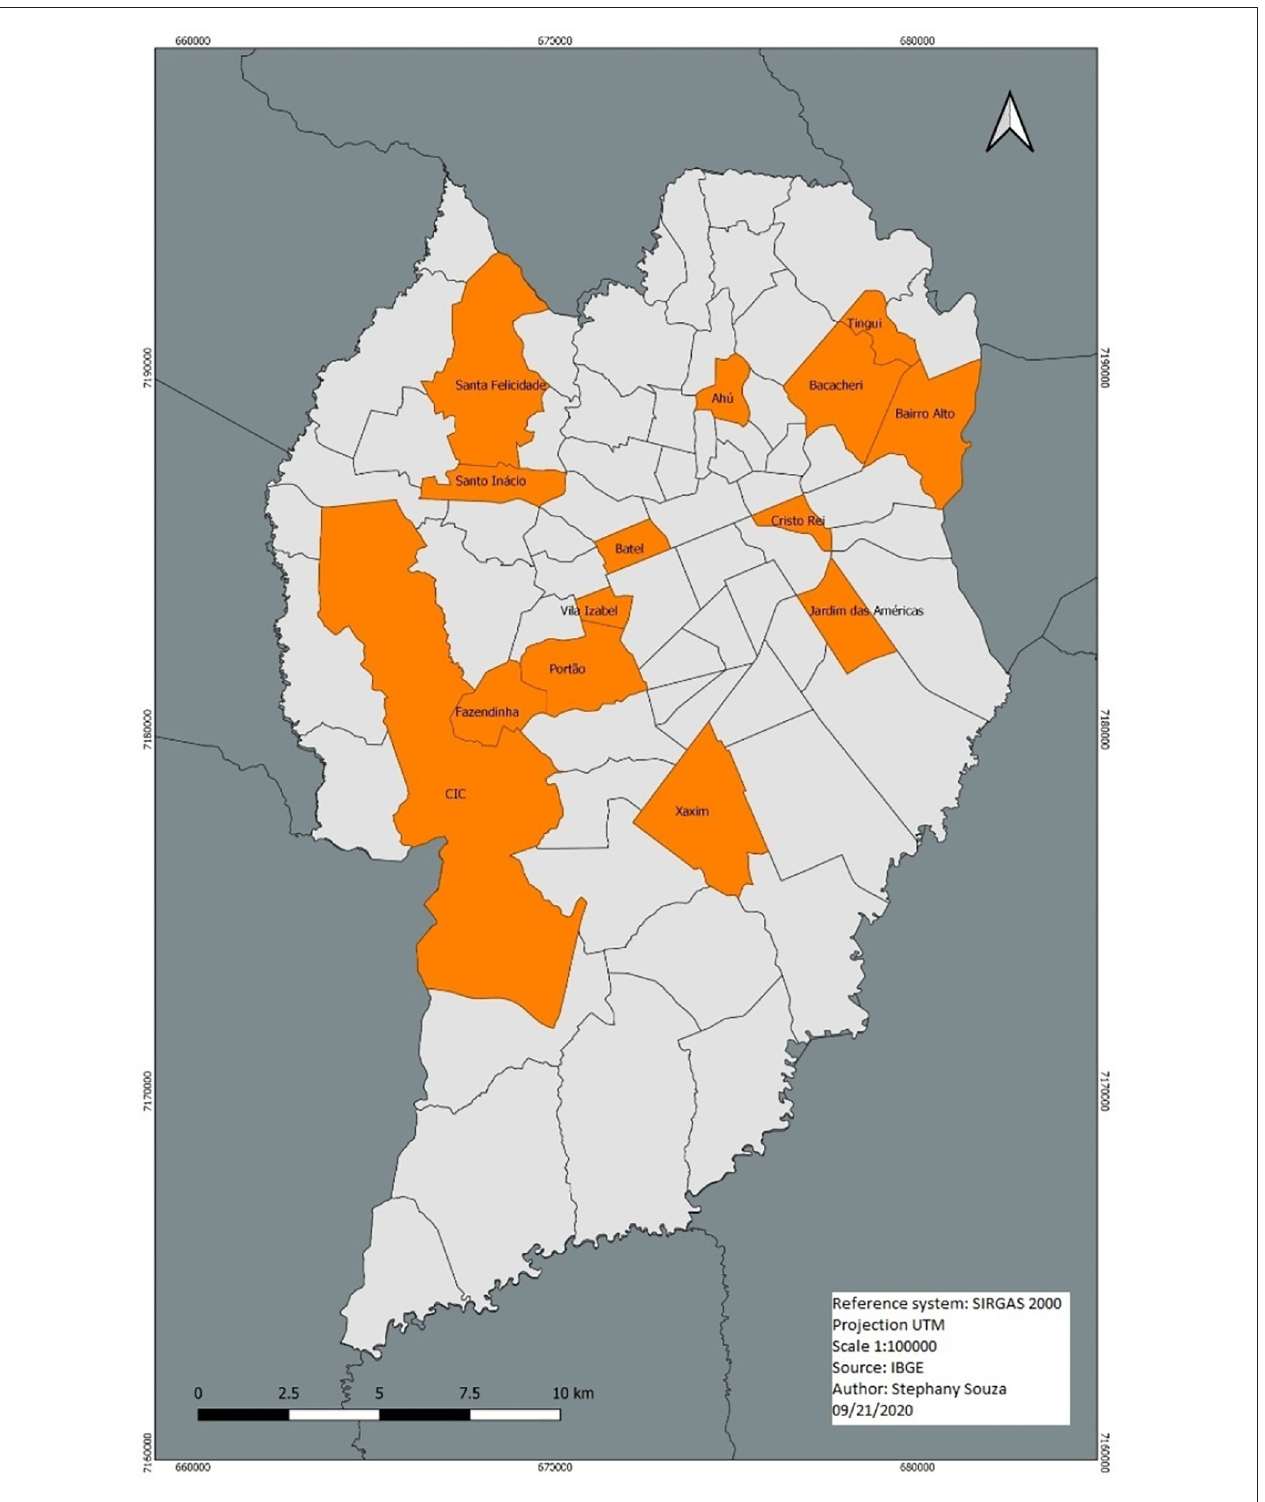
FIGURE 1 | Districts of Curitiba where production of reusable masks was identified.